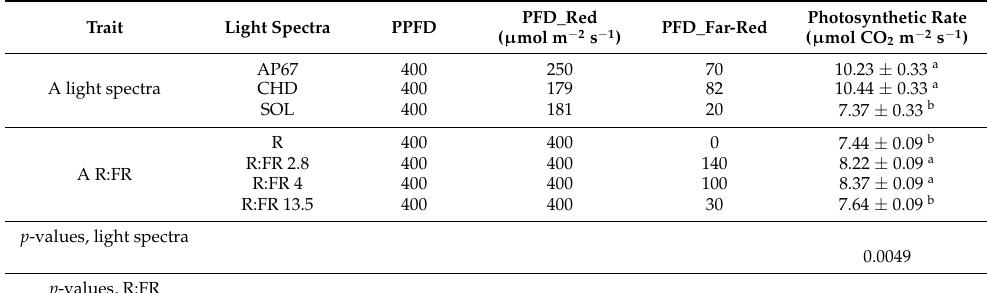
Table 1. Photosynthetic rate ( µ mol CO 2 m − 2 s − 1 ) of the strain KAN under the different light spectra (SOL, AP67 and CHD) as well as different R:FR ratios. Results are presented as mean values ± standard errors (means ± SEs). Means followed by at least one identical lower-case letter did not differ significantly at α = 0.05, within a strain or flower, as indicated by a Tukey test.